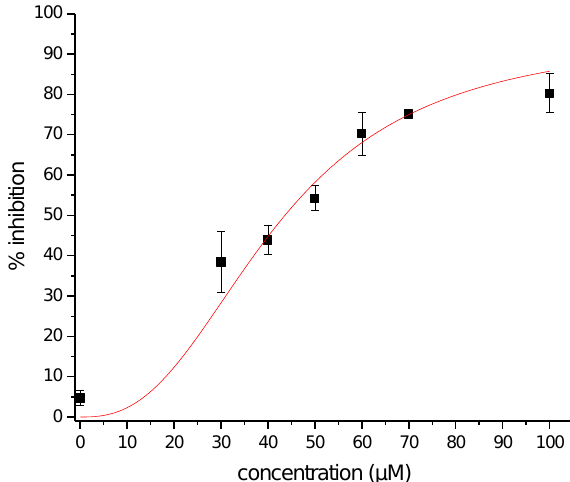
Figure 3. Concentration dependence of the inhibitory activity of lithospermic acid on NC(11-55)- induced destabilization of cTAR. The data points were obtained at 20 °C with 0.1 µM Alexa488- 5′ - cTAR- 3′ Dabcyl and 1 µM NC(11-55) in 25 mM TRIS-HCl pH 7.5, 30 mM NaCl and 0.2 mM MgCl 2 . Each point was done in duplicate and corresponds to the mean +/ − SEM. The solid line corresponds to the fit to the data points using Equation (2).